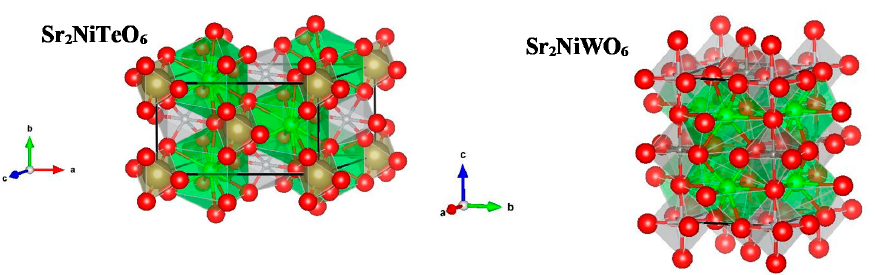
Figure 3. Crystal structures of the synthesized compounds visualized by VESTA [49].